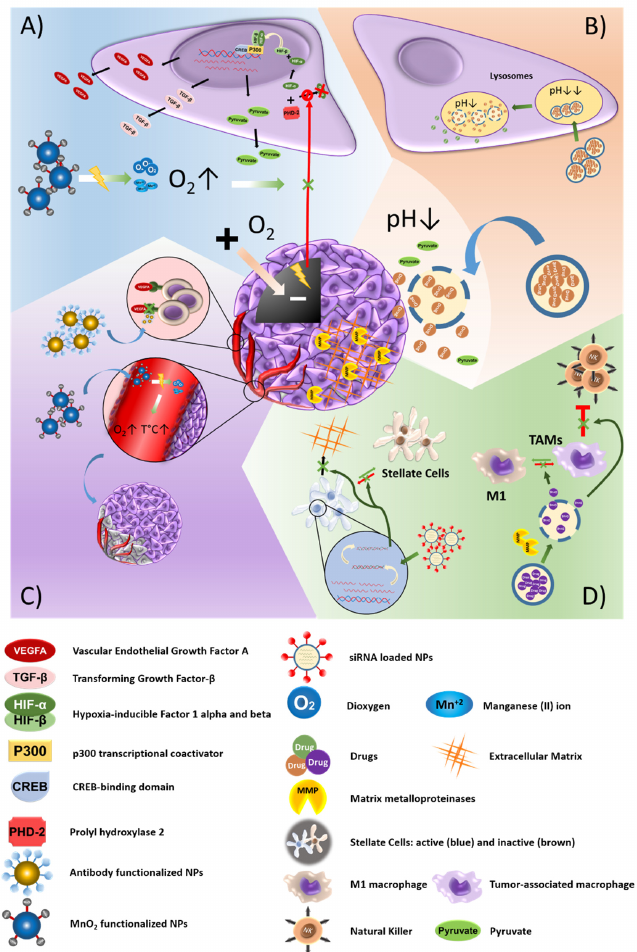
Figure 3. Nanoparticle-based strategies to exploit the characteristics of the tumor microenvironment (TME). ( A ) Systems that focus on the presence of hypoxic areas are based on the generation of oxygen, increasing its local levels and, therefore, eliminating the stress situation which results from hypoxia. Reversal of the hypoxic state blocks the expression of HIF-1 α and, consequently, reduces the acidification of the extracellular medium and the expression of pro-angiogenic factors. ( B ) Medium acidification can be exploited by using pH-sensitive nanoplatforms with the aim of both achieving a controlled release of their load and buffering the medium to reestablish the pH. ( C ) Some strategies also focus on the active targeting of the neo-vasculature through the use of NPs that specifically recognize it by means of antibodies and the application of radiation. ( D ) In addition, some cellular components of the TME can be reprogrammed by using certain drugs, or inactivated by vehiculation of